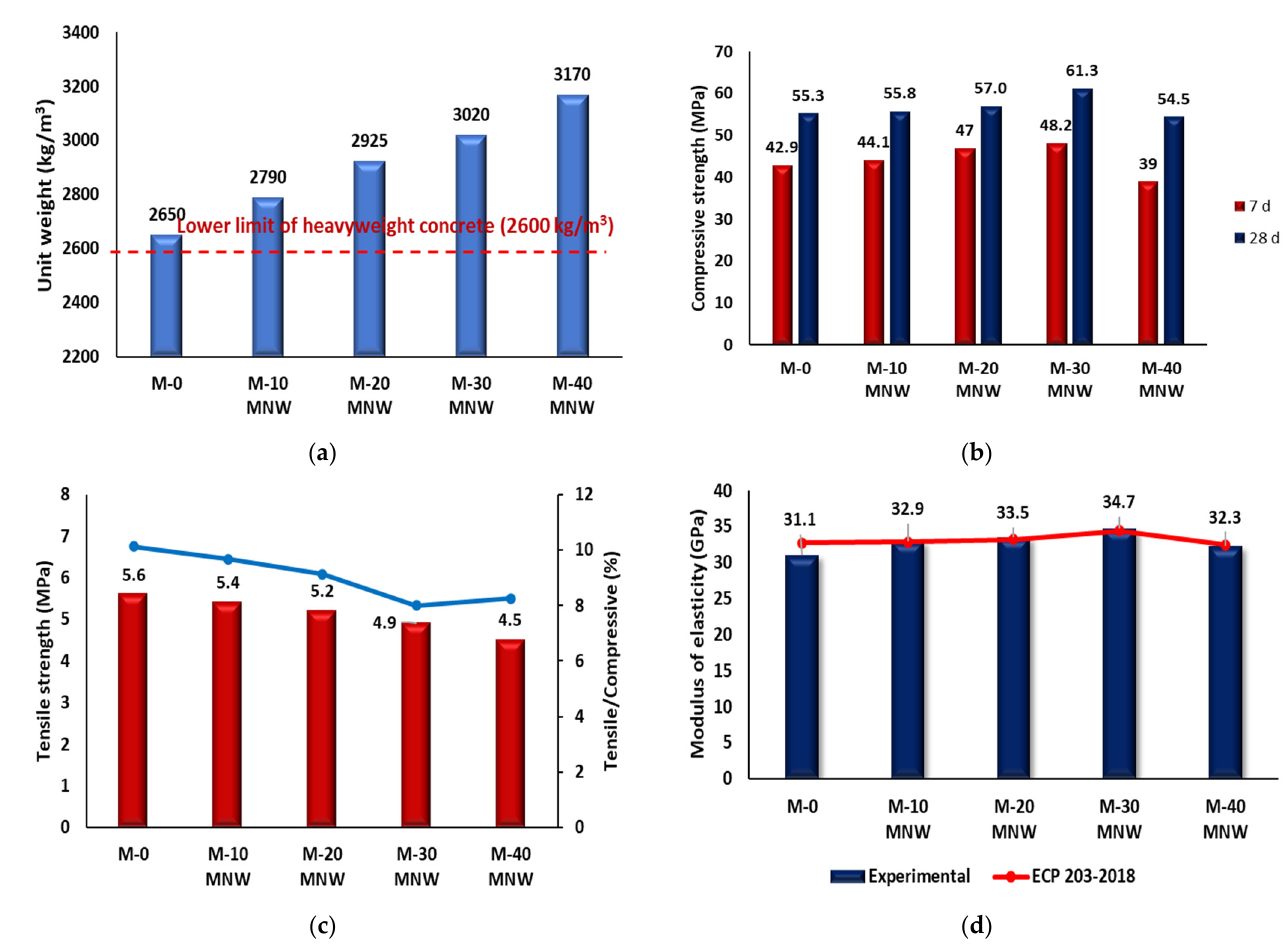
Figure 4. ( a ) . Unit weight of all mixtures at 28 d; ( b ) compressive strength of all mixtures at 7, 28 d; ( c ) tensile strength of all mixtures at 28 d; ( d ) modulus of elasticity for all mixtures at 28 d.